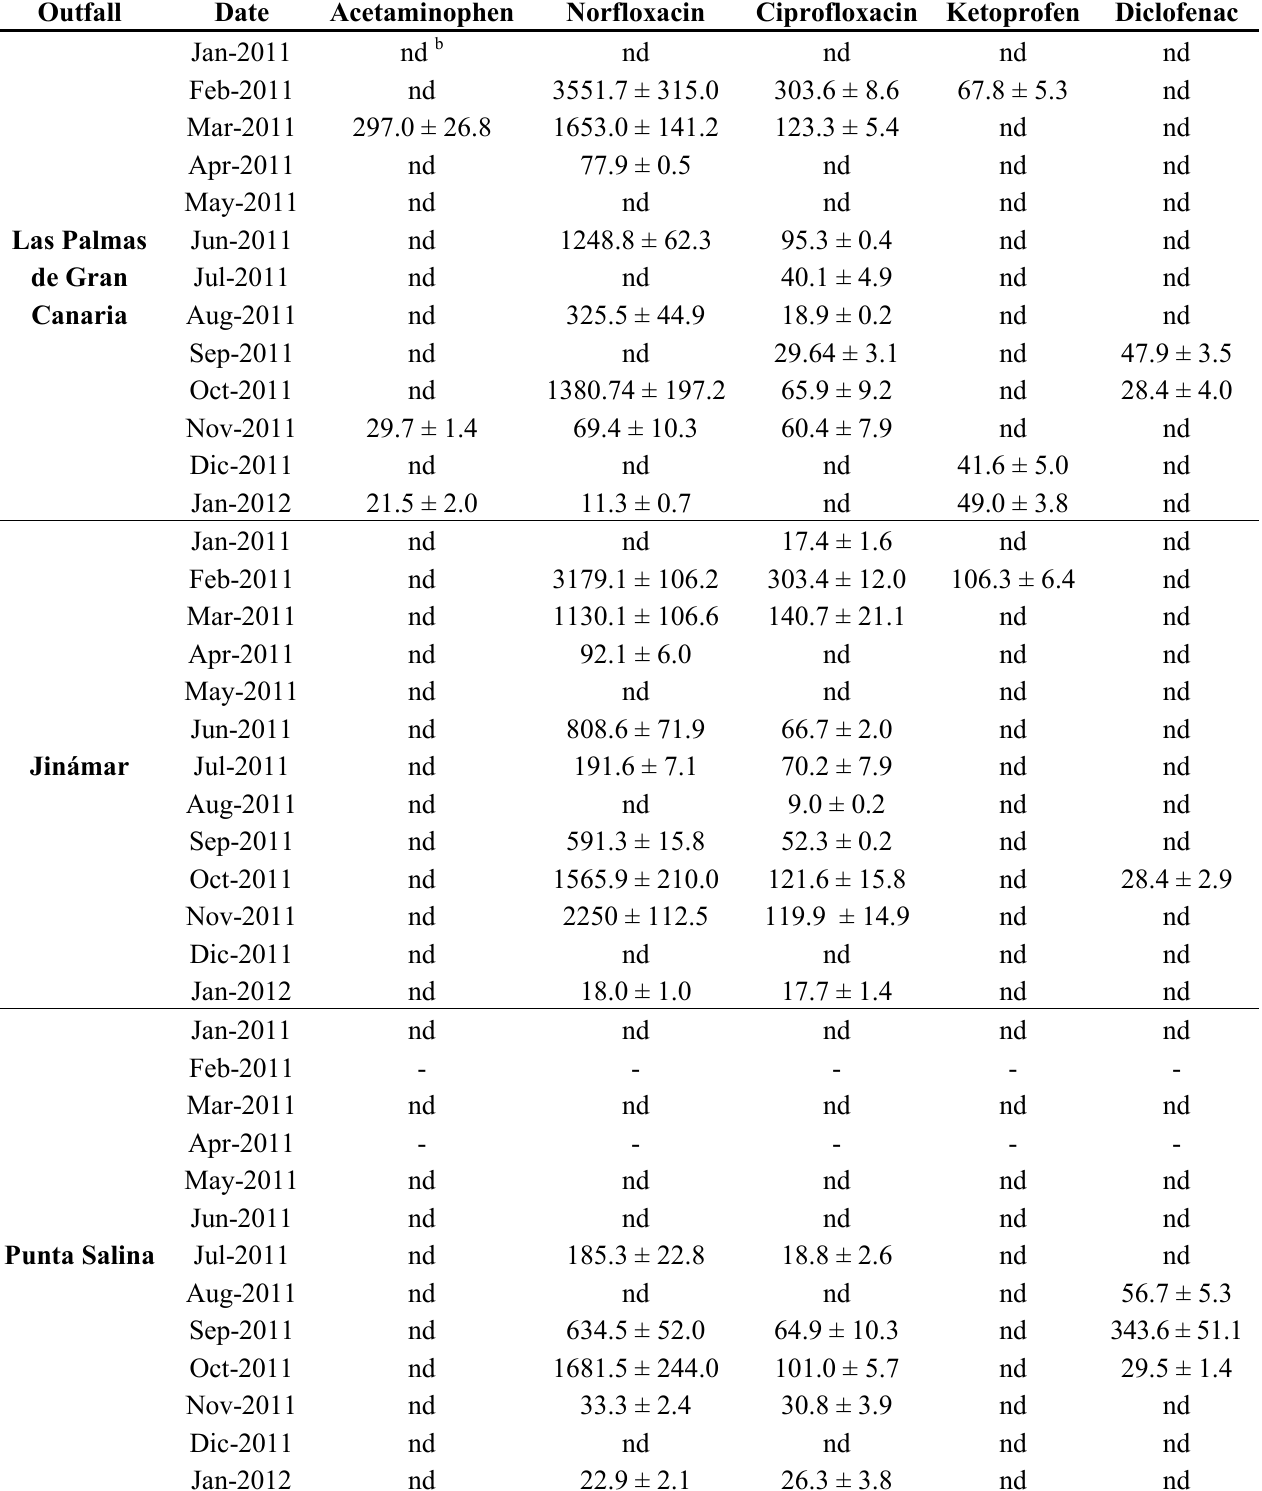
Table 4. Concentrations in ng·L −1 found in seawater from four different outfalls in Gran Canaria island.